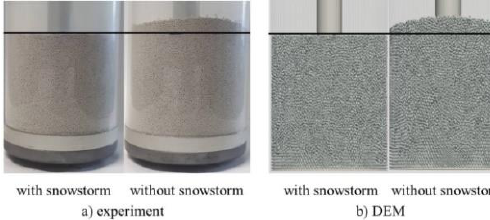
Fig. 5. Experimental and numerical packing of sandstone